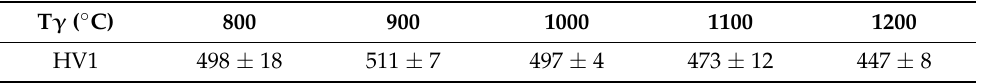
Table 3. Dependence of hardness HV1 (Vickers hardness, test force 10N) on austenitization